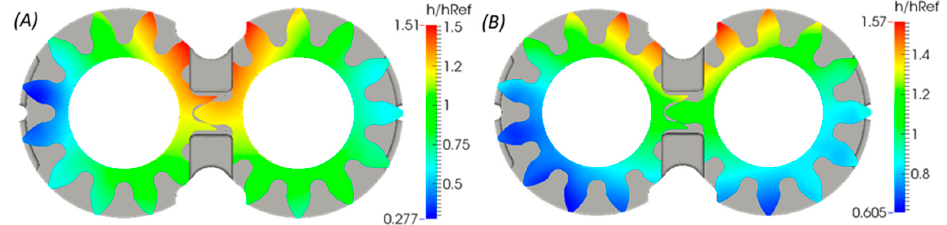
Figure 19. Film thickness distribution in the lateral gap at 1500 rpm and p / p ref = 0.56 as predicted by ( A ) Full Film model; ( B ) Mixed Film model.